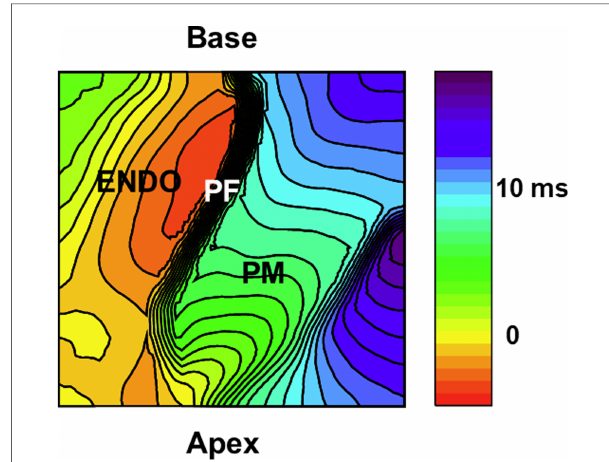
FIGURE 5 Activation patterns from purkinje-papillary-myocardium. Image of the papillary muscles from the RV septum from a 5 mm×5 mm region. Activation map of the papillary muscle (PM) under sinus rhythm. An example of activation isochrones (1 msec apart) is shown for a right ventricular papillary muscle in a perfused rabbit heart. A fast wave of depolarization appears fi rst along the PFs lying along the papillary (base to apex), followed by the fi ring of papillary APs before the spread of electrical activity along the endocardium (ENDO). The Supplementary Movie S7 depicts the sequence of activation demonstrating a wave of PF depolarization followed by the PM depolarization preceding the activation of the endocardium (ENDO) by 2 – 5